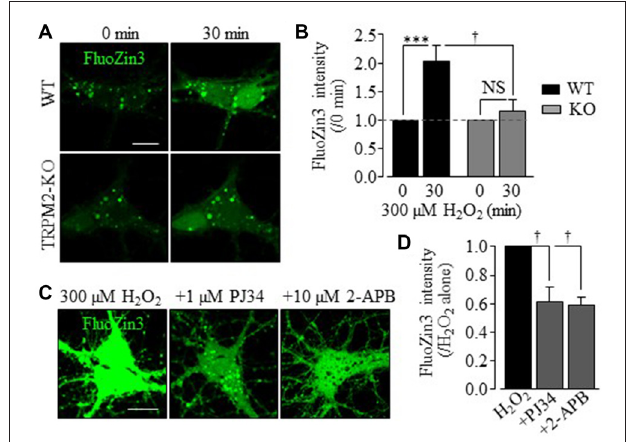
FIGURE 2 | TRPM2 is critical in H 2 O 2 -induced increase in the [Zn 2 + ] c in hippocampal neurons. (A) Representative time-lapse confocal images showing FluoZin3 (green) fluorescence in WT (top two panels) and TRPM2-KO (bottom two panels) neurons before and after exposed to 300 µ M H 2 O 2 for 30 min. (B) Mean FluoZin3 fluorescence intensity under indicated conditions from 9 to 11 independent experiments with a total of 40 neurons examined. All values are normalized to the basal fluorescence level in matched experiments. ∗∗∗ p < 0.005 indicates difference from the basal level and † p < 0.05 for difference between WT and TRPM2-KO neurons treated with H 2 O 2 . NS, no significant difference. (C) Representative confocal images showing FluoZin3 fluorescence in WT neurons treated with 300 µ M H 2 O 2 for 30 min or treated with 1 µ M PJ34 or 10 µ M 2-APB, 30 min prior to and during exposure to H 2 O 2 . (D) Mean FluoZin3 fluorescence intensity in neurons under indicated conditions, expressed relative to the fluorescence level in neurons exposed to 300 µ M H 2 O 2 alone, from four to five independent experiments with each experiment examining 20–25 neurons. † p < 0.05 indicates difference from neurons treated with H 2 O 2 alone. Scale bar is 10 µ m in (A,C) .